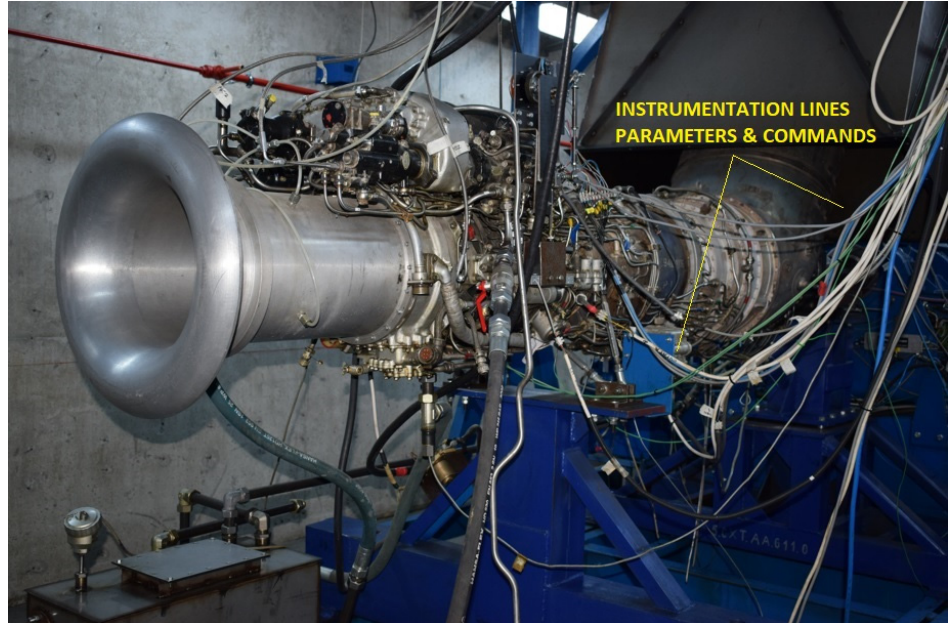
Figure 4. TV2-117A engine instrumentation lines.